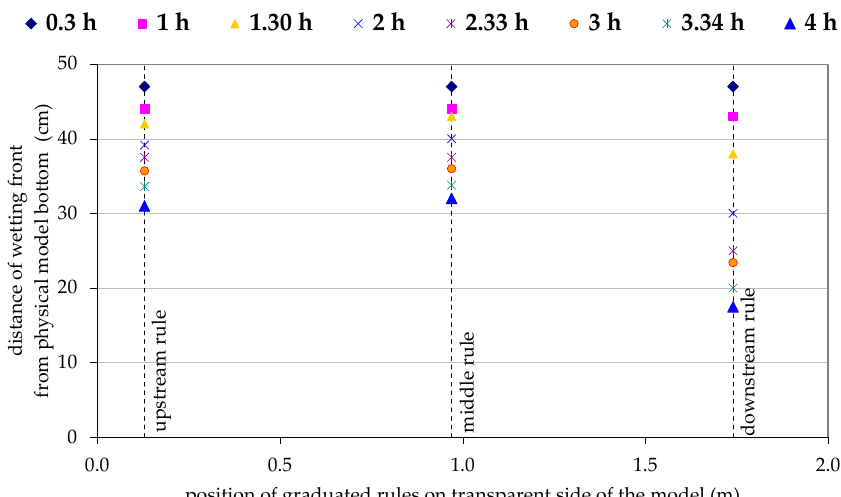
Figure 8. Time position of the wetting front, returned by its tracing through visual readings on the three graduated rules (upstream, middle, downstream) on the transparent side of the physical model, during first artificial rainfall.